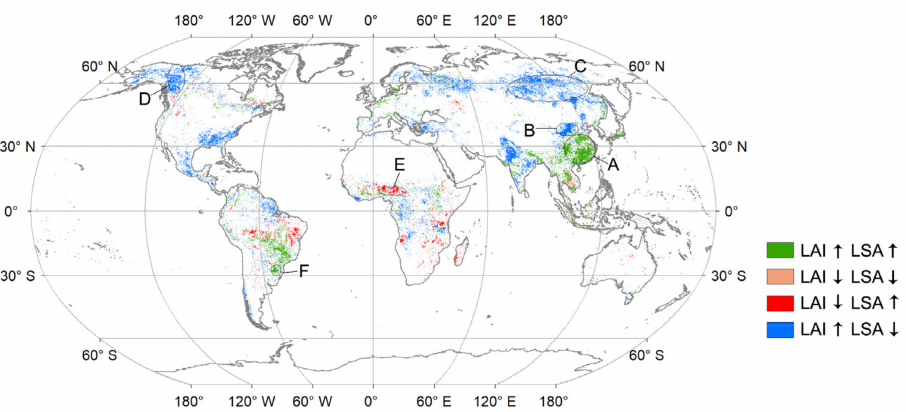
Figure 9. Spatial distribution of the LSA response categories from 2000 to 2019. The regions A, B, C, D, E, and F are southeastern China, the Loess Plateau, Siberia, Alaska and northwestern Canada, southern edge of the Sahel Desert, and southern Brazil,